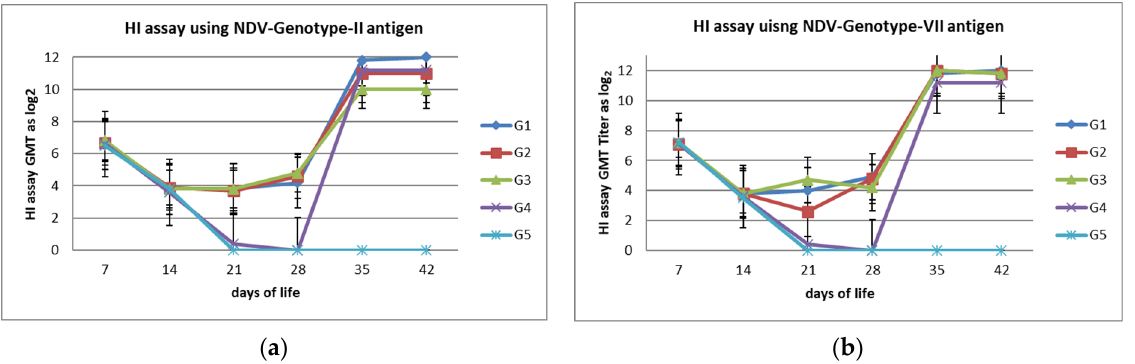
Figure 2. ( a ) Mean HI titer ±SD in vaccinated and non-vaccinated groups using LaSota Antigen. ( b ) Mean HI titer ±SD in vaccinated and non-vaccinated groups using NDV-genotype-VII Antigen.